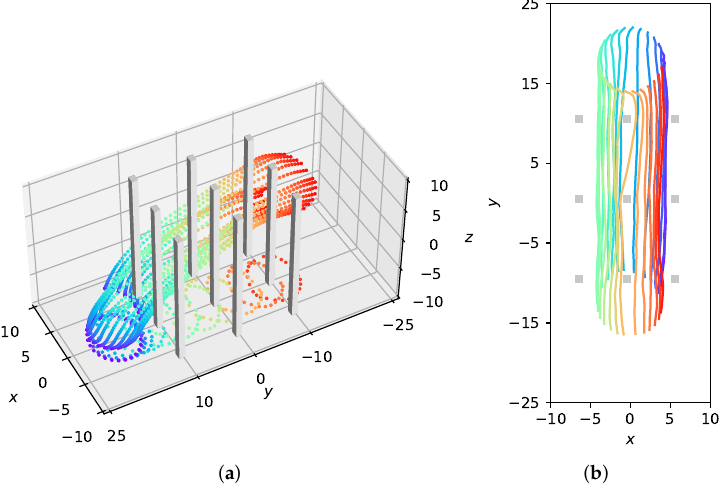
Figure 6. The visualization of the executed trajectories for large-scale UAVs formation flying through an obstacle-rich area. ( a ) Full view of the trajectories. ( b ) xoy -plane projection trajectories.